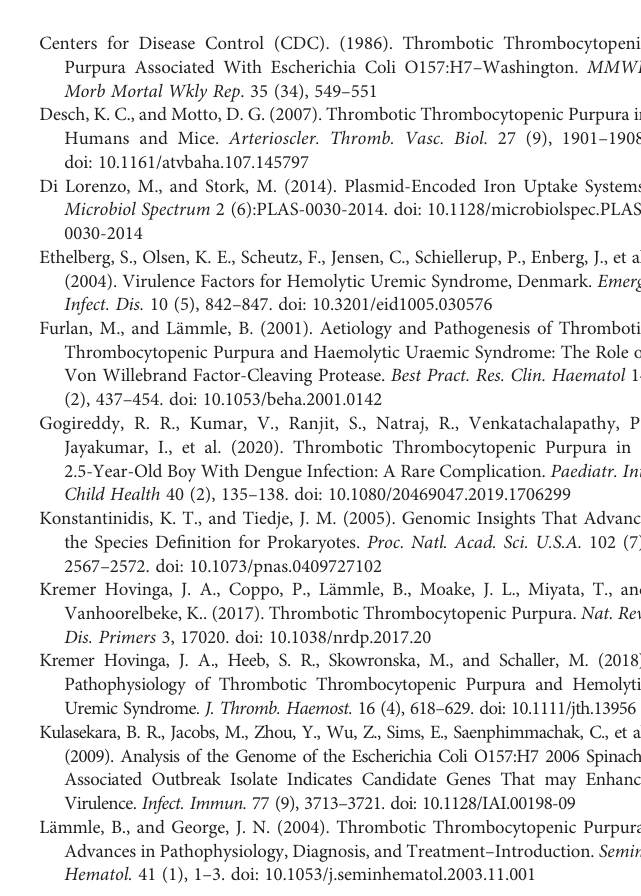
Supplementary Figure 1 | Amino acid sequence alignment of FlRd According to the result of phylogenetic analysis and searching for template by SWISS-MODEL, 7 FlRd proteins were included in the alignment and 5lmc.2, the protein with highest similarity, were used as crystal structure reference in the alignment. E. coli _5lmc.2 and E. coli _6etb.1 stands for two most similar FlRd protein with known crystal structure searched by SWISS-MODEL. Amino acid sequence and crystal structure were obtained on Protein Data Base (PDB, https://www.rcsb.org/). S. bongori = Salmonella bongori _WP_000026020.1 (protein nearest to FlRd of S. Typhimurium_zhang on the phylogenetic tree). H. alvei = Hafnia alvei _WP_025802316.1, H. paralvei = Hafnia paralvei _WP_130335968.1 (two FlRd protein furthest to FlRd of S. Typhimurium_zhang on the phylogenetic tree). E. coli _TW14359=FlRd on E. coli O157:H7 isolate TW14359. S. Typhimurium_zhang=FlRd on S. Typhimurium_zhang. Amino acid residues coordinating catalytic iron atoms were marked by * according to previous